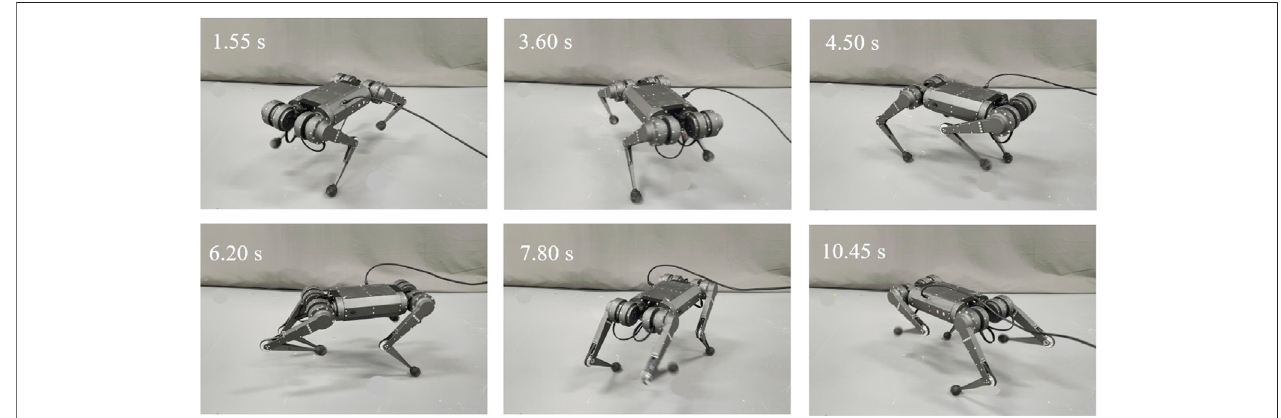
FIGURE 5 | Screenshots of the quadruped robot spinning on the fl at ground with an ACS controller.